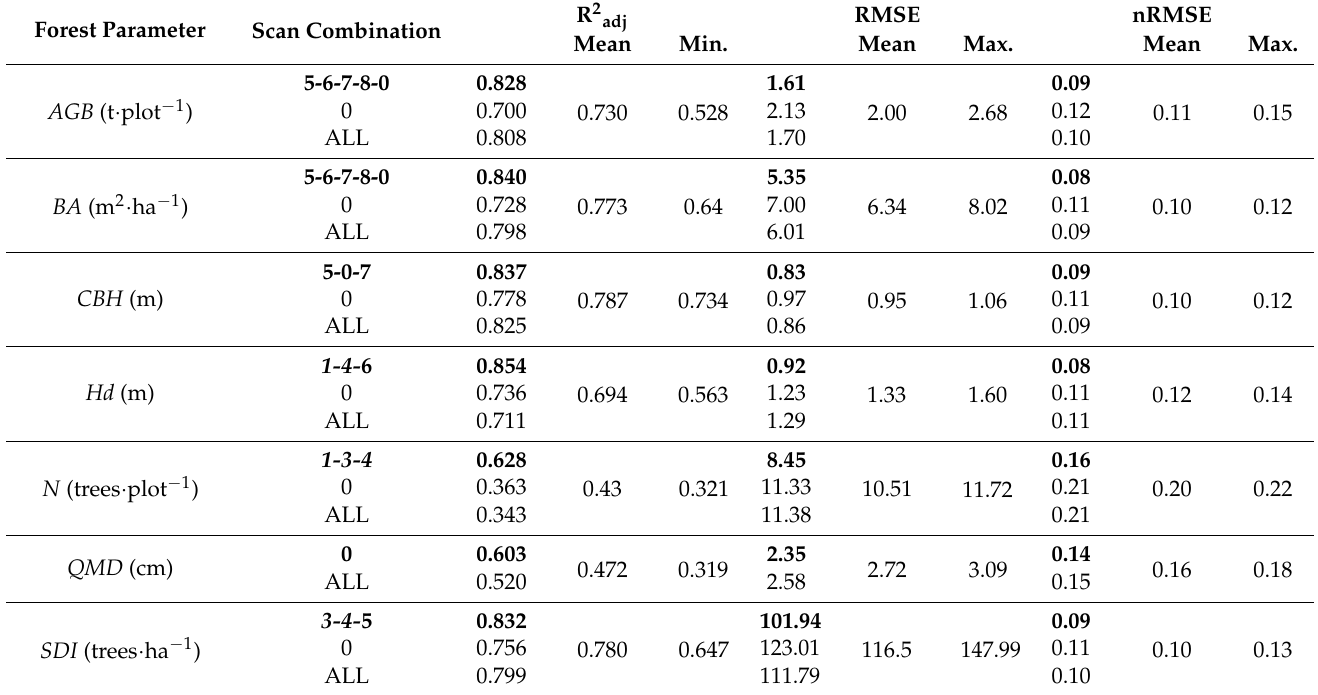
Table 4. Summary of R 2 adj , RMSE, and nRMSE indicators for each of the estimated forest parameters and the different scan combinations: using a specific scan combination (in bold), the central one as a single scan (0), and the nine scans (ALL). The Mean, Min., and Max. columns refer to the average, minimum, and maximum values obtained for all the combinations